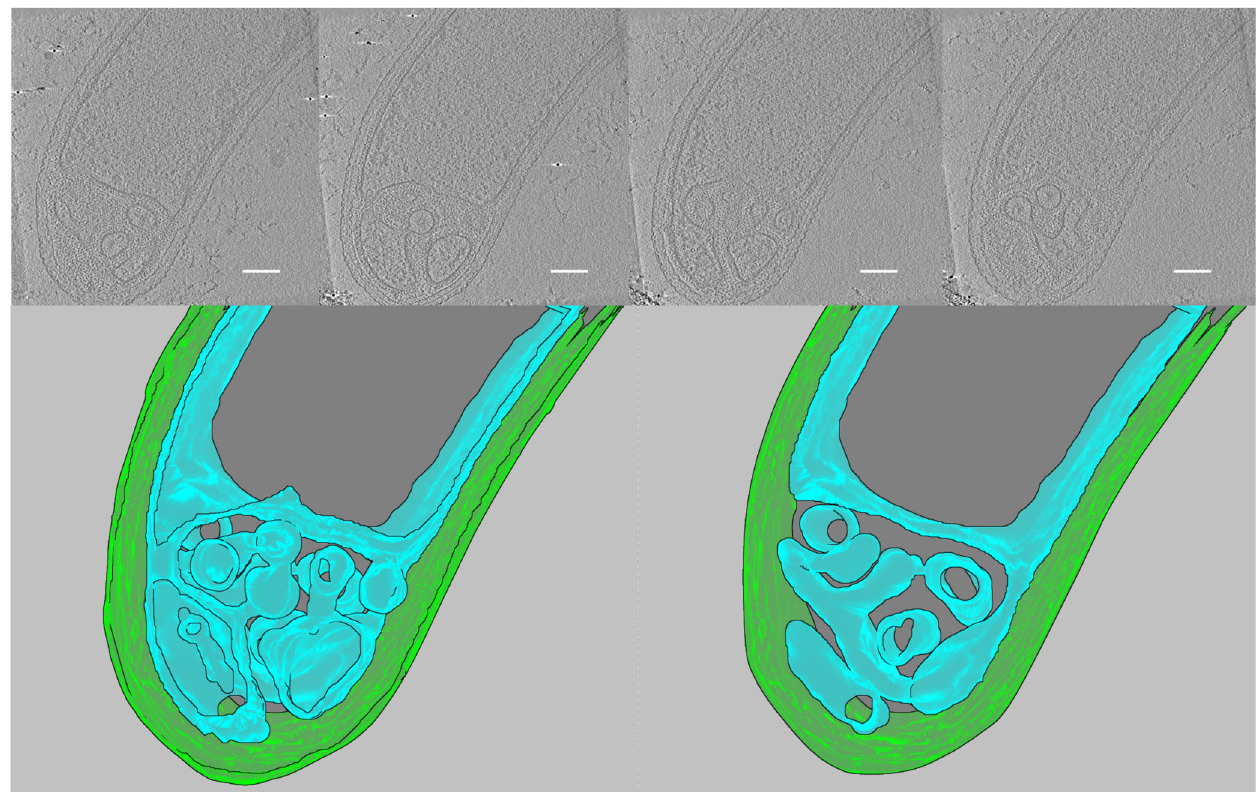
Fig. 3 G. sulfurreducens invagination of the inner membrane. Cryotomograph slices and 3D model of a G. sulfurreducens cell grown at – 0.17 V vs SHE on a holey-carbon/gold cryo-EM grid as anode for 24 h. Cryotomogram shows how ICM seems to form by invagination of the inner membrane. Top – selected tomogram slices in the z axis displaying sections of the invagination. Bottom – 3D model of the inner membrane and outer membrane through (bottom left) the entire thickness of the modeled volume and (bottom right) the model sliced approximately in half in the z axis to show the ICM pro fi le at a different depth. Scale bar: 100